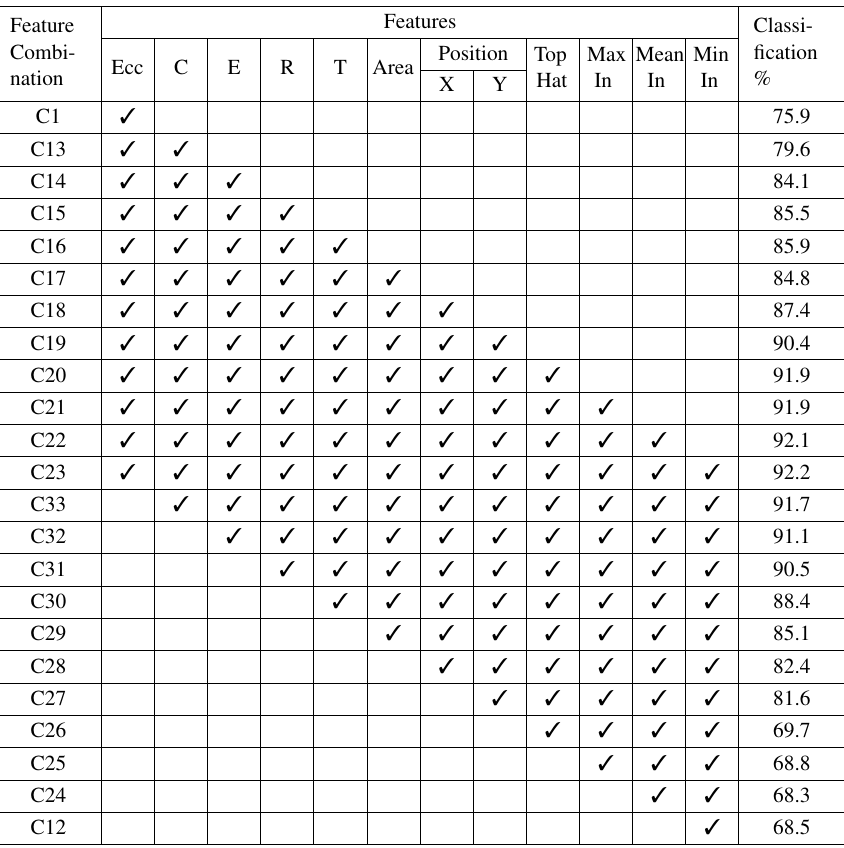
Table 4. Classification with different feature